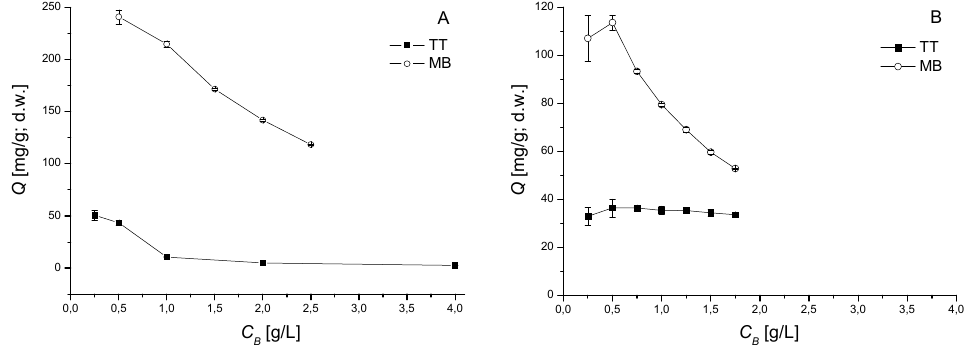
Figure 4. The effect of biomass concentration C B on thioflavin T (TT) and methylene blue (MB)